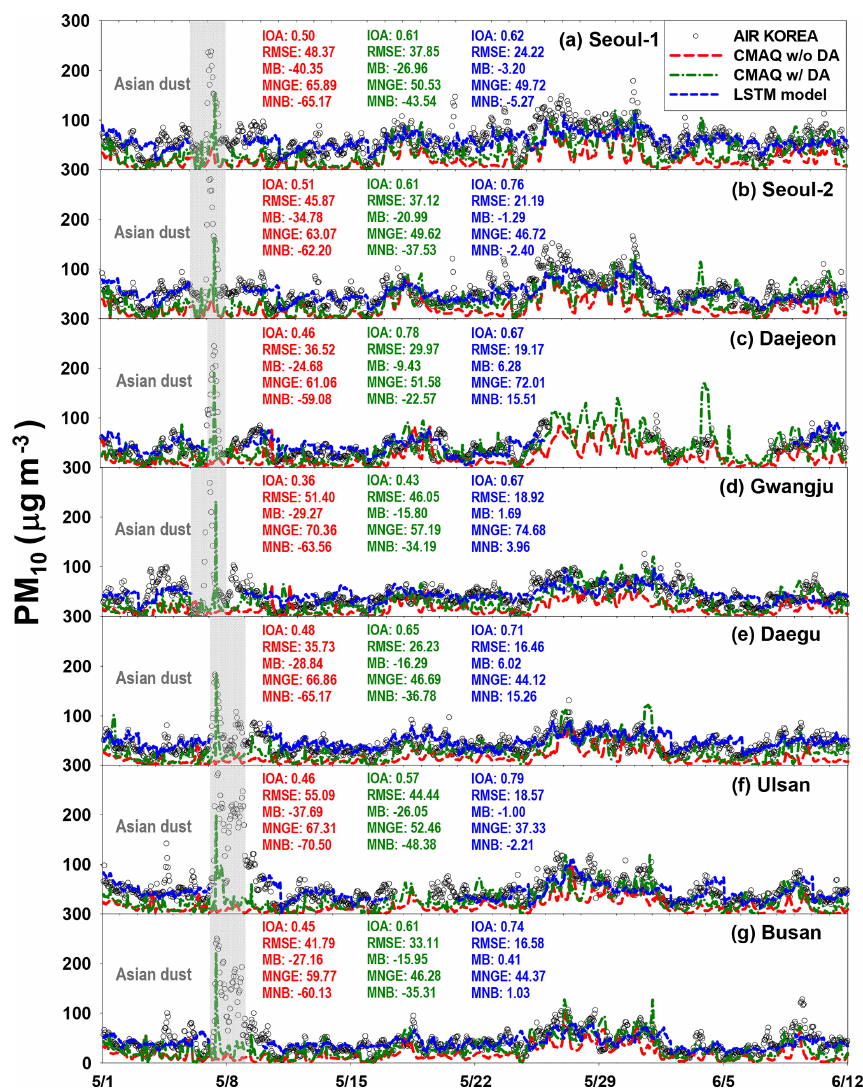
Figure 6. Comparisons between the CMAQ-calculated, LSTM-predicted, and the observed PM 10 . Black open circles show observed PM 10 at seven sites. Dashed green and dashed red lines represent CMAQ-predicted PM 10 with and without data assimilation, respectively. Dashed blue lines represent LSTM-predicted PM 10 . From 26 May to 7 June, the LSTM-based PM 10 predictions at the Daejeon site were not performed due to the continuous missing